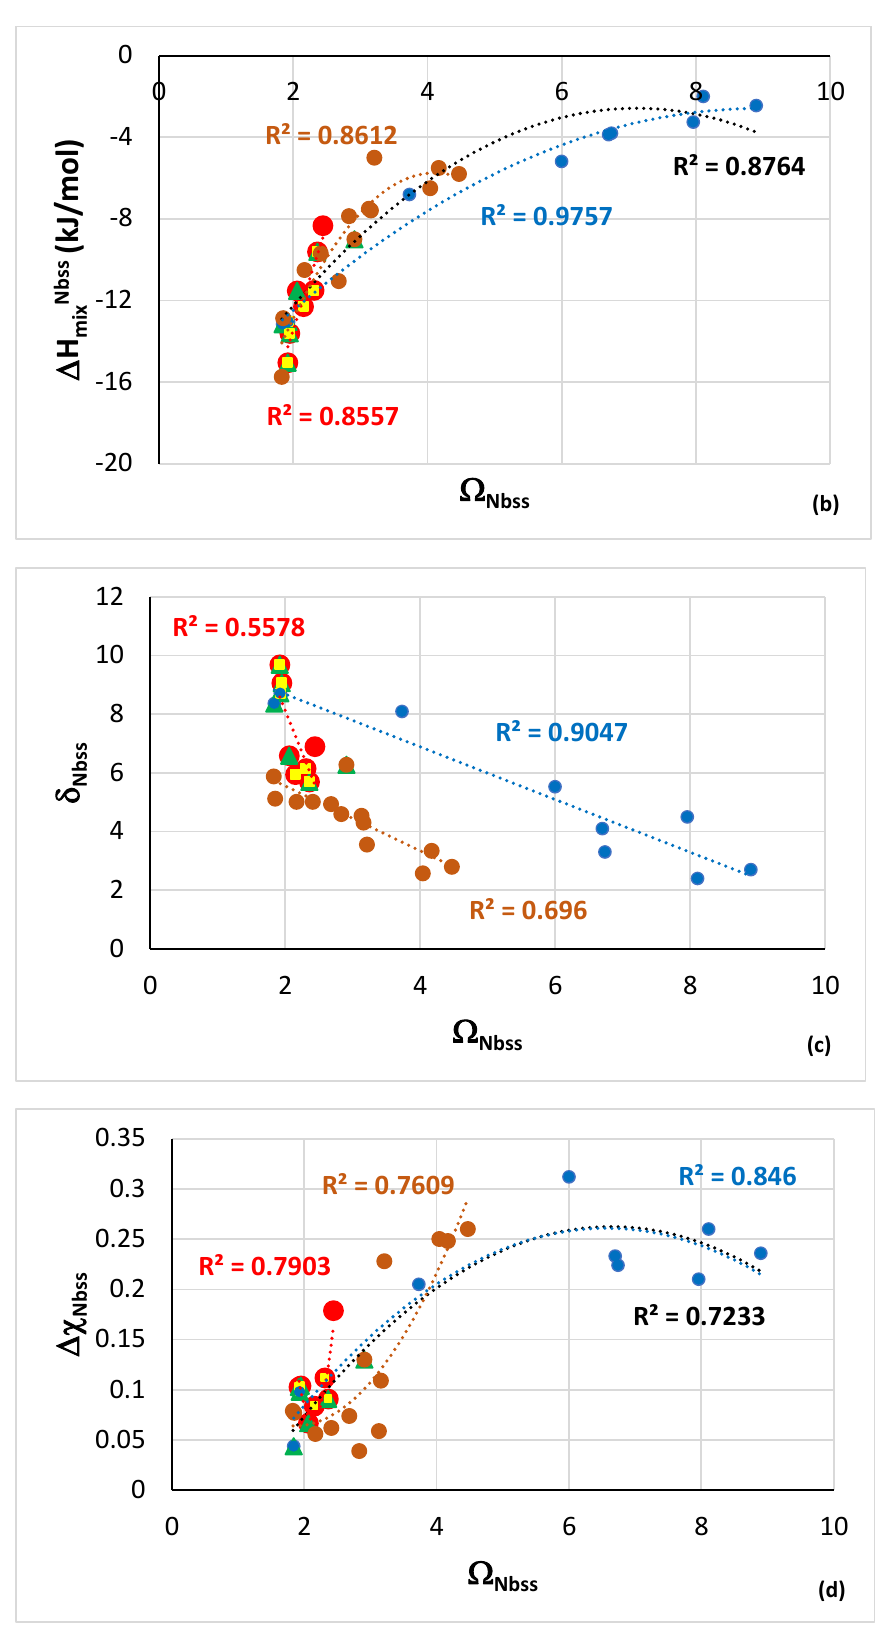
Figure 2. ( a ) Alloy entropy of mixing versus solid solution entropy of mixing, and ( b – d ) relationships of the solid solution parameter Ω with the solid solution ( b ) enthalpy of mixing, ( c ) parameter